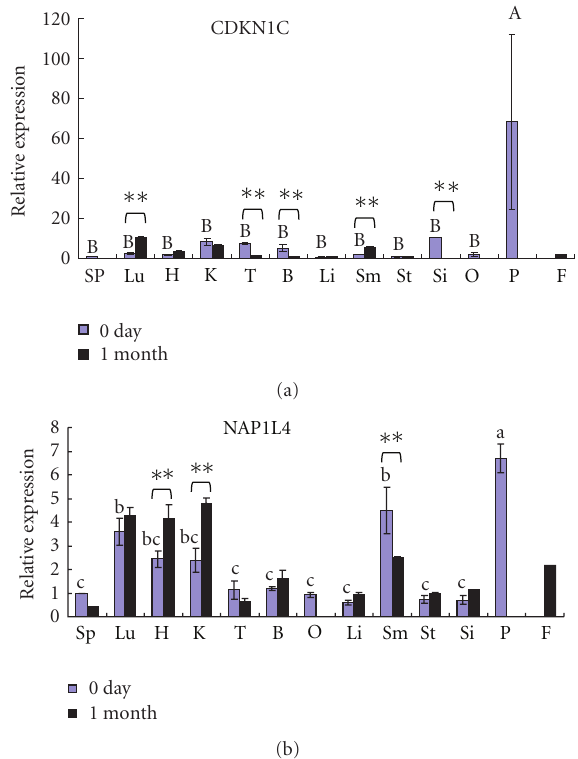
Figure 1: Tissue expression of porcine CDKN1C (a) and NAP1L4 (b). The expression values are normalized to RPL32 and expressed as mean ± SE. Sp: spleen; Lu: lung; H: heart; K: kidney; T: tongue; B: bladder; O: ovary; Li: liver; Sm: skeletal muscle; St: stomach; Si: small intestine; P: placenta; F: fat. ABC-column means within 0 day of age bearing di ff erent superscripts di ff ers significantly P < 0 . 05 (lowercase) and P < 0 . 01 (uppercase). ∗∗ P < 0 .